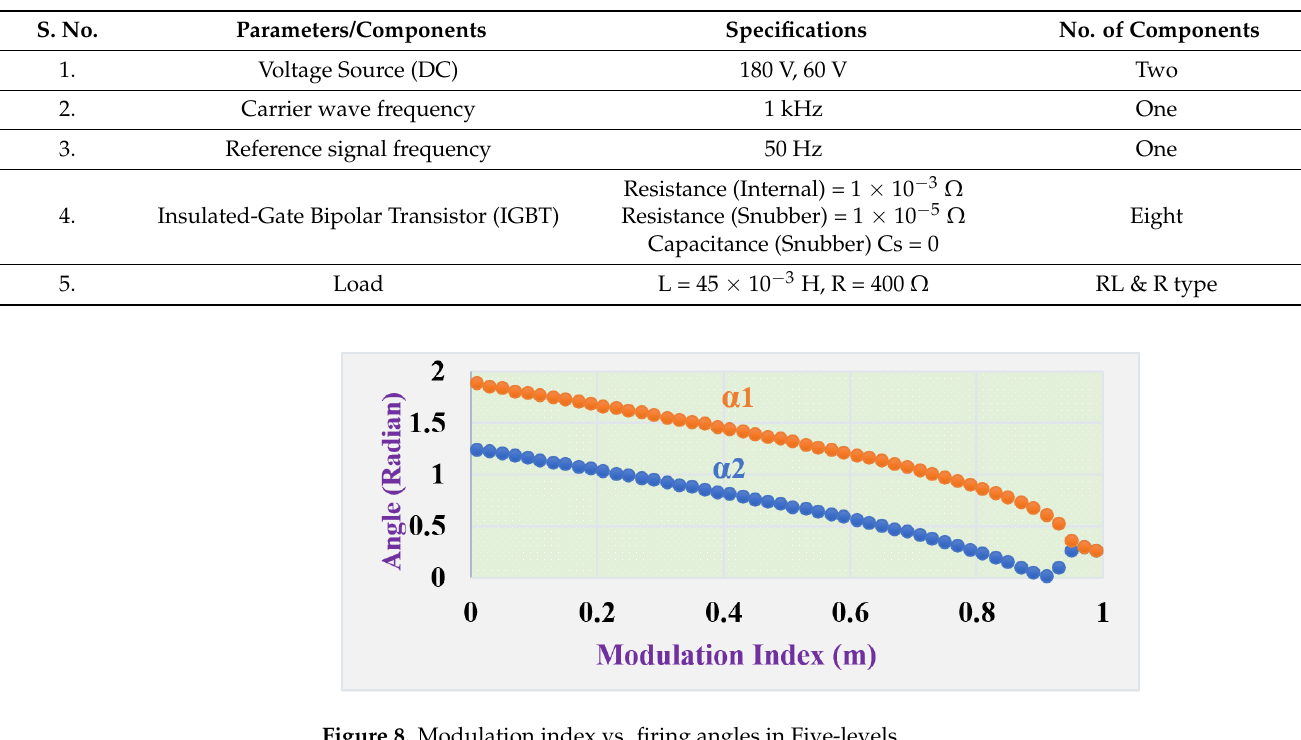
Figure 8. Modulation index Vs firing angles in Five-levels.